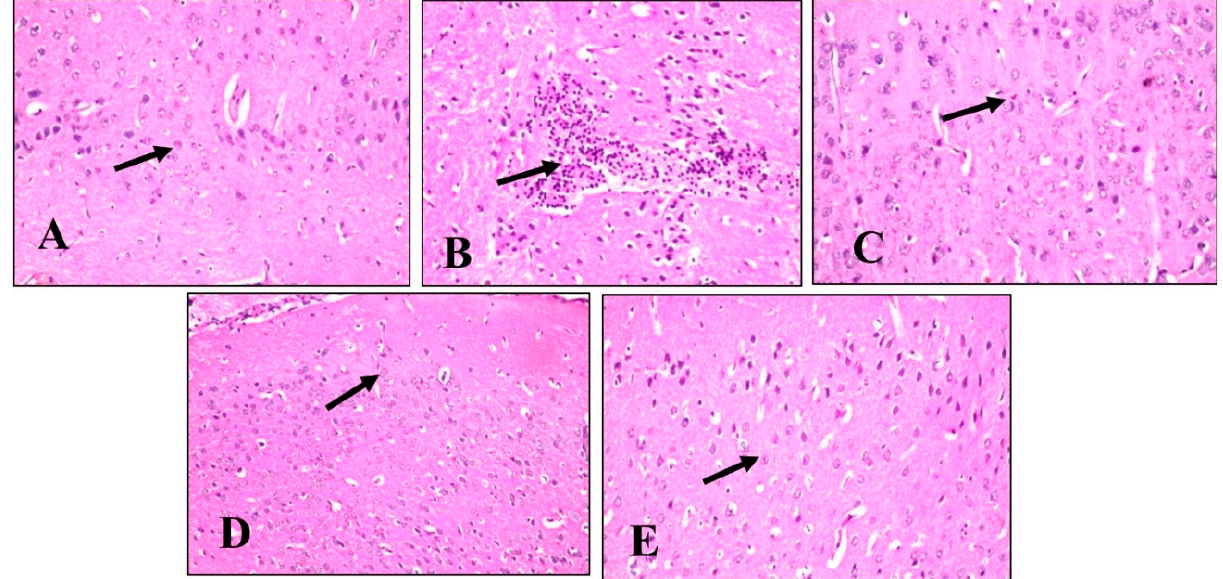
Figure 6. Histopathology of mice brain (Cerebral Cortex sections) with H&E × 40. ( A ) Normal control group showing normal histological findings (Black arrow-normal neuron). ( B ) LPS-administered mice group showing nuclear pyknosis and degeneration of the neurons with focal gliosis (Black arrow). ( C ) BME-administered mice group showing normal histological findings (Black arrow-normal neurons). ( D ) BDMF-administered mice group showing normal histological findings (Black arrow-normal neurons). ( E ) BBF-administered mice group showing normal histological findings (Black arrow-normal neurons). BME: B. armeniaca methanolic extract; BDMF: B. armeniaca dichloromethane fraction; BBF: B. armeniaca butanol fraction; LPS: lipopolysaccharide.